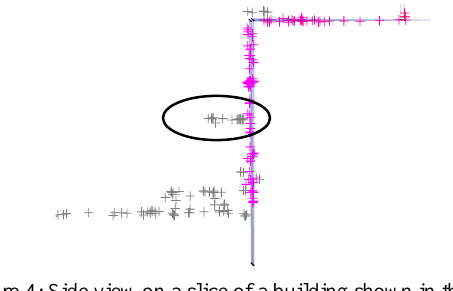
Figure 4: Side view on a slice of a building shown in the initial (blue) and adjusted model (grey). Structures not represented by the model are well covered with tie points (e.g. the roof plane highlighted by the ellipse) and are not assigned to the model plane. The initial and the estimated model planes have very similar parameters.